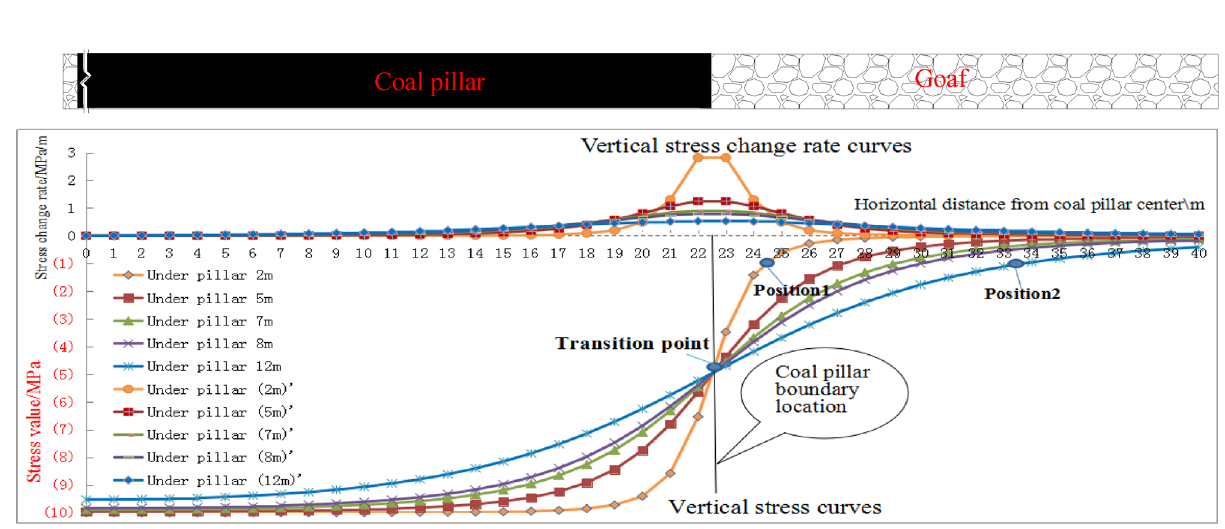
Figure8. Stress variation curve at different floor depths under coal